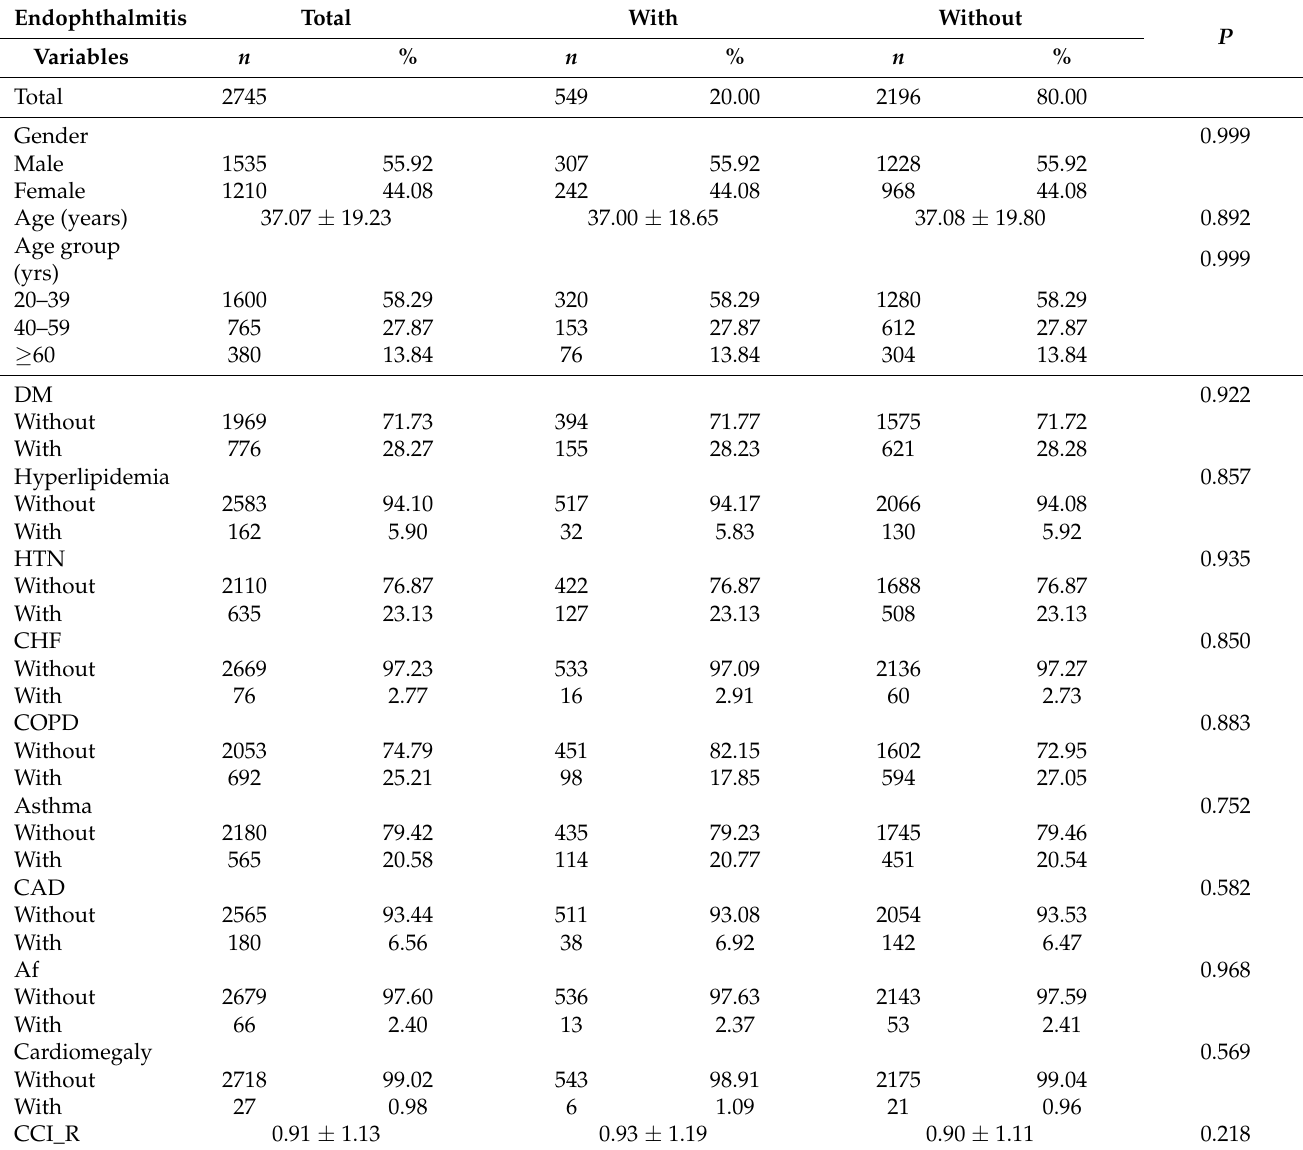
Table 1. Baseline characteristics of the study